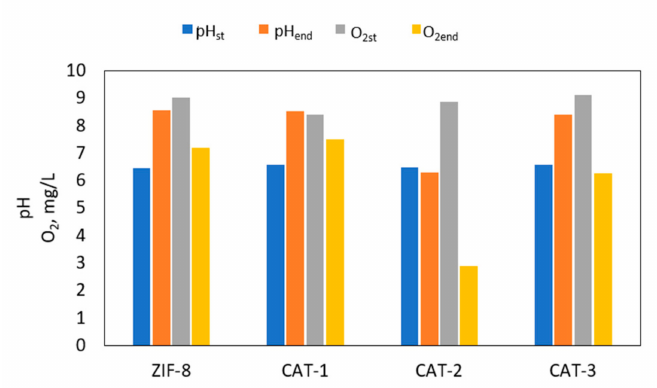
Figure 8. Changes in pH and dissolved oxygen concentration after photocatalytic tests (240 min).